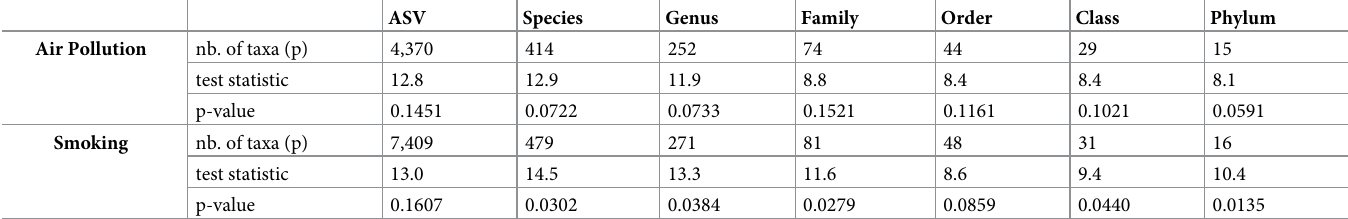
Table 6. Compositional equivalence test. Test statistic for high-dimensional data suggested by [56] and one-sided randomization-based p-values for 10,000 permutations of the intervention assignment following a matched-pair design. ASV